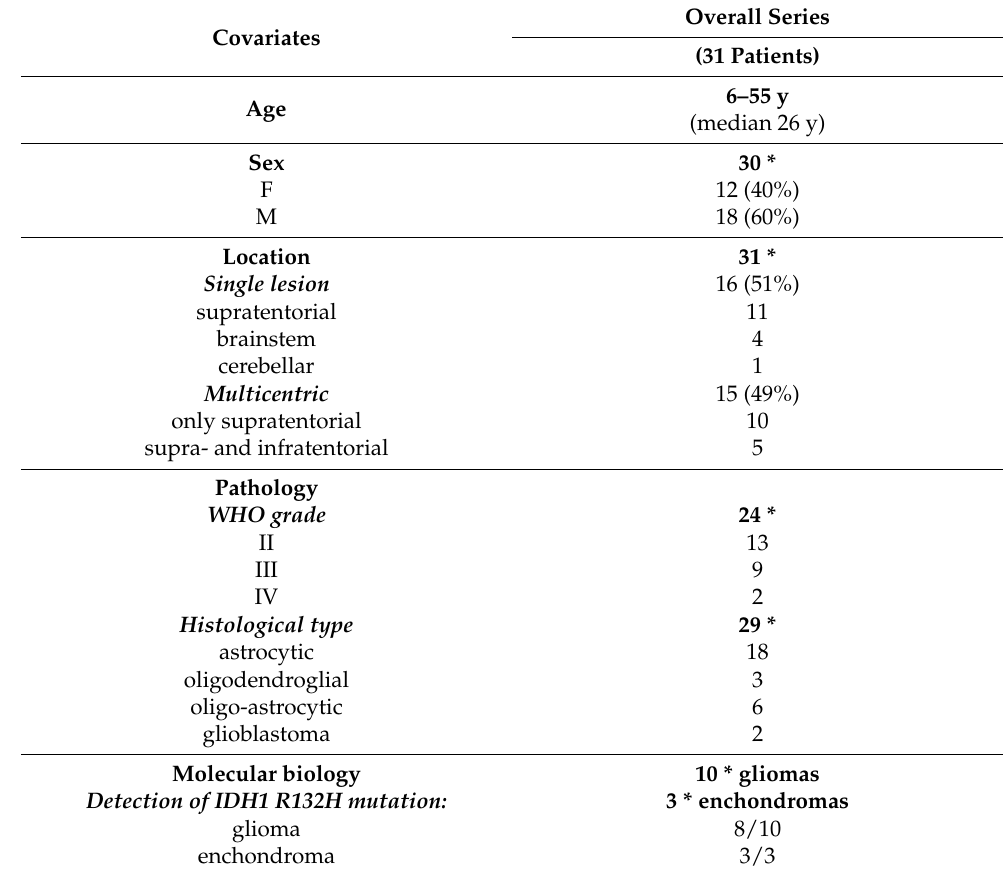
Table 2. Summary of the epidemiological and pathological data of the 31 reported cases of OD with brain glioma.